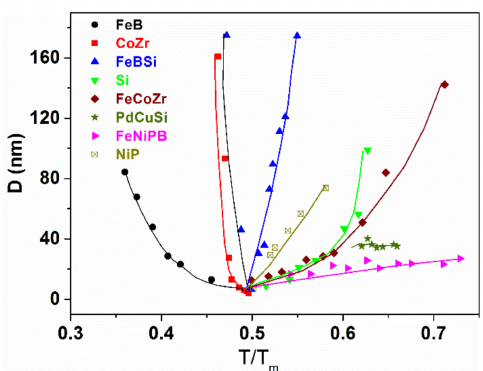
Figure 26. Grain size versus the normalized temperature ( T / T m ) for various glass-forming metallic systems ( T : onset temperature of crystallization, T m : experimentally determined melting point of the alloy and grain size arises from experiments.) Adapted from [100], with permission from Elsevier,